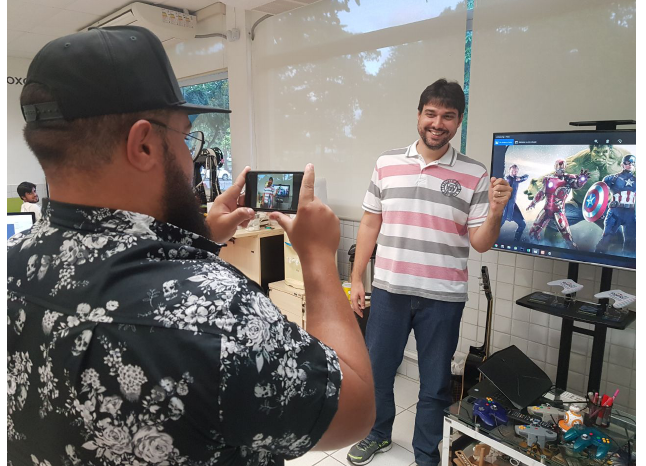
Figure 13. Two users participating on the tests performed. The goal was to take a picture of each user interacting with 3D virtual objects placed in fixed position in space, as shown in the screen of the cell phone hold by the user on the left.